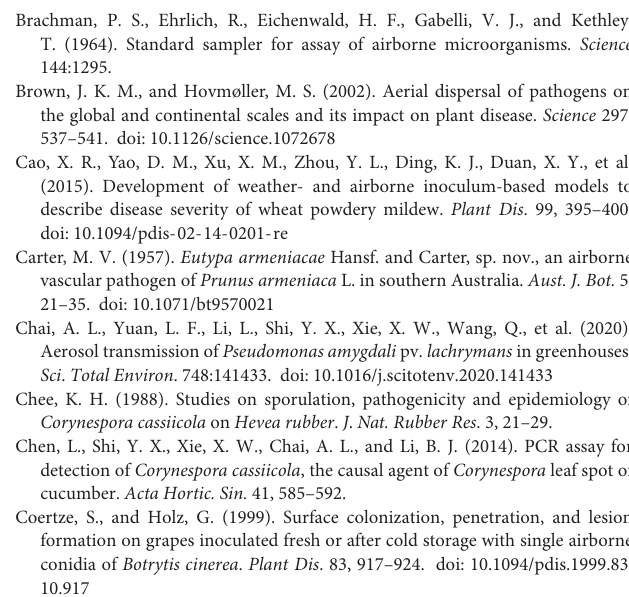
Supplementary Figure 1 | Characterization of hygromycin-resistant Corynespora cassiicola ( C . cassiicola :HygR) and C . cassiicola . (A) Morphological characteristics